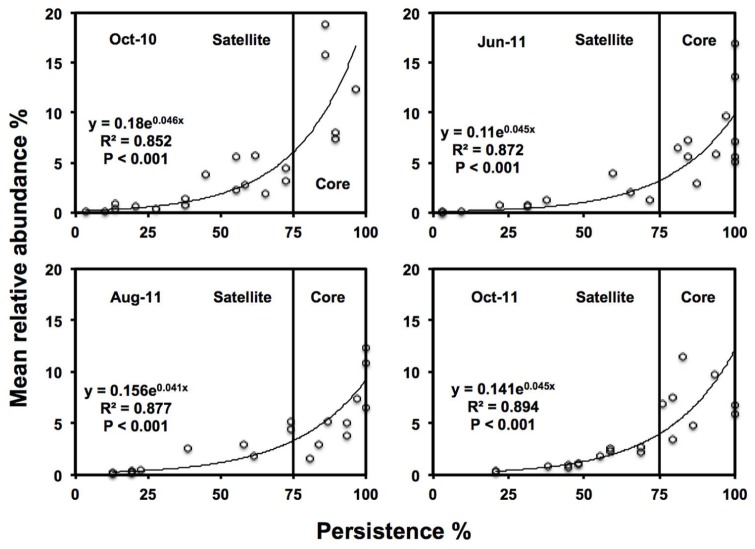
Persistence and abundance of the twenty-one AMF TRFs, at each sampling time. Where the vertical line is the threshold for ‘core’ taxa at 75% persistence.